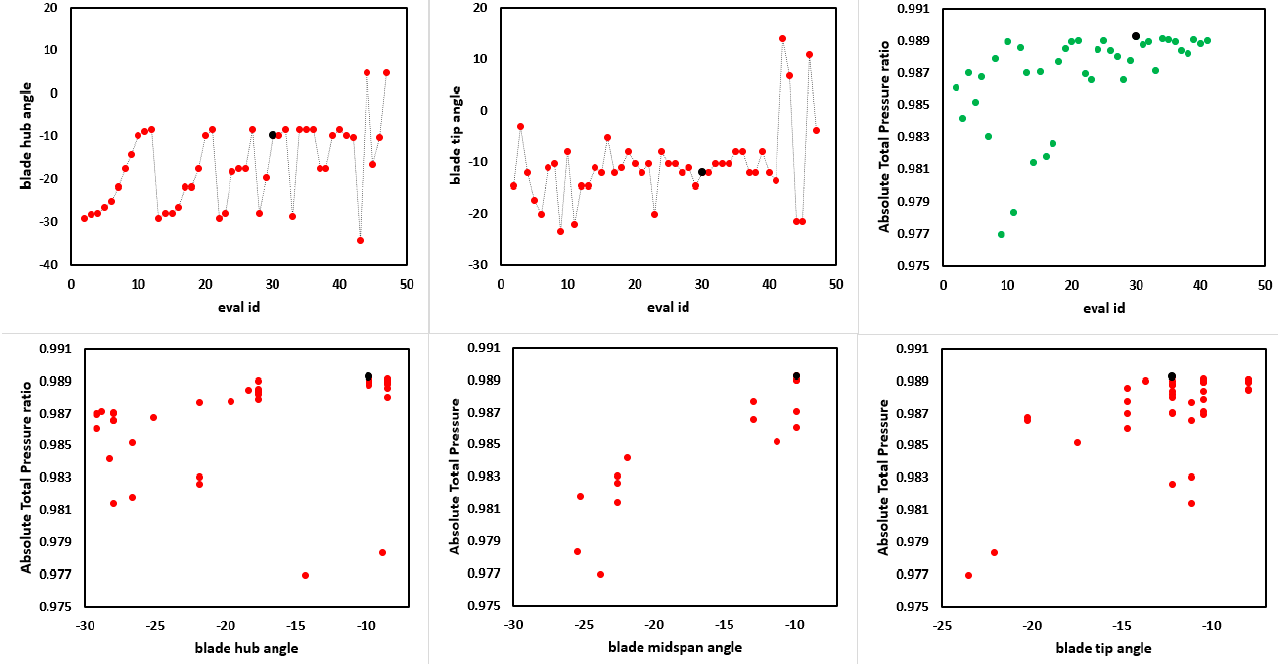
Figure 27. Blade angles varied with each evaluation shown as red, their values, and resulting absolute total pressure ratios in green. The optimums are represented by black dots.